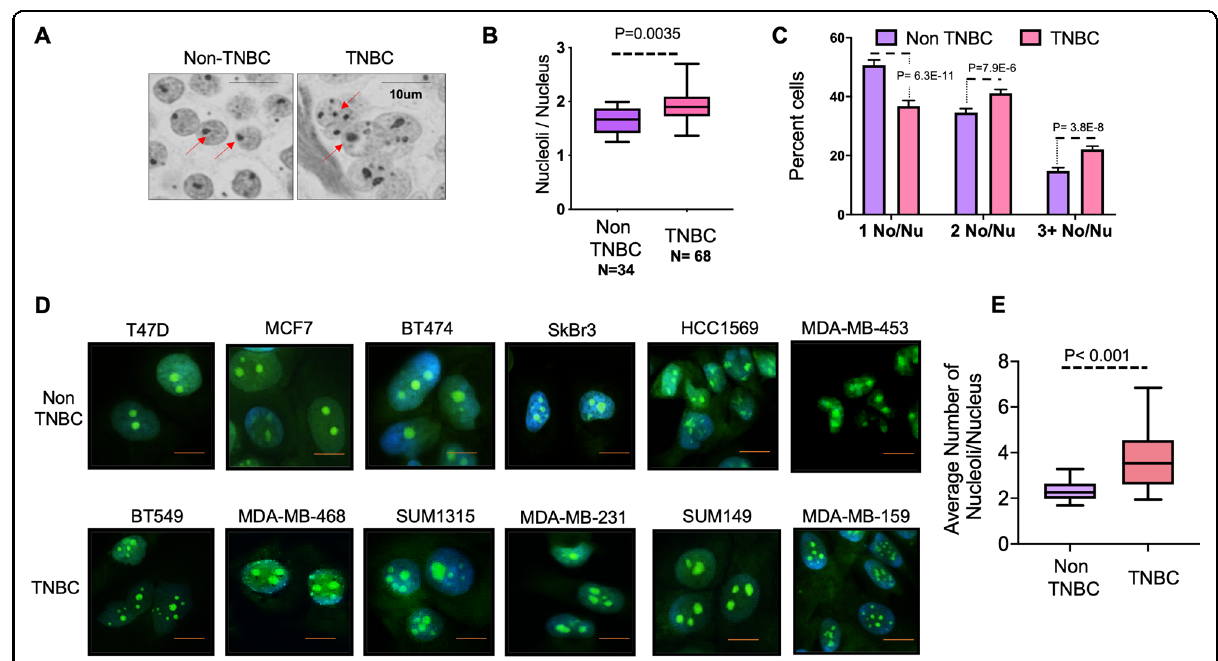
Fig. 1 TNBC cells have more nucleoli than non-TNBC cells. A Representative image of AgNOR stained human breast cancer tissue sections classi fi ed as TNBC or non-TNBC. Red arrows point at nucleoli. B Quanti fi cation of nucleolar number (using AgNOR staining) in human breast cancer tumor tissue sections classi fi ed as TNBC or Non-TNBC. Number of nucleoli per nucleus from cells in each specimen were counted. The data is represented as a box and whiskers plot. C Cells from each human breast cancer tumor tissue section, classi fi ed as TNBC or non-TNBC were separated into groups of cells with one nucleolus/nucleus, two nucleoli/nucleus, and three or more nucleoli/nucleus. These groups were represented as percent cells in each group. D Representative images of NucleolarID TM stained cells from TNBC or Non-TNBC cell lines. Focused bright green staining demarcates nucleoli. DAPI staining (blue) marks the nucleus. E Quanti fi cation of nucleolar number (using NucleolarID TM staining) in human breast cancer cell lines. The number of nucleoli per nucleus from six TNBC and six non-TNBC cell lines was counted. The data is represented as a box and whiskers plot and was signi fi cantly decreased in the non-TNBC cell lines ( P < 0.001). Signi fi cance was determined using a T -test and all error bars indicate